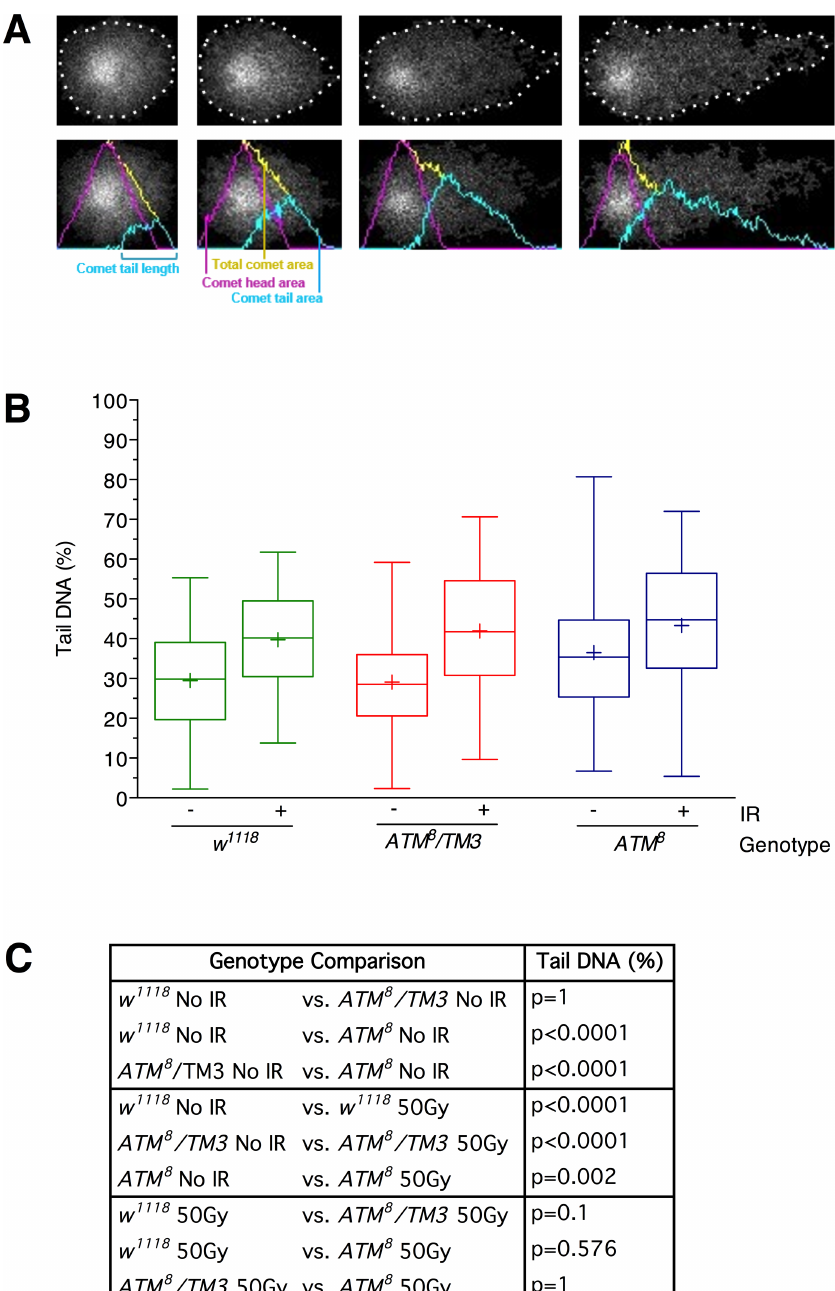
Fig 4. DNA damage accumulates in the brain of ATM 8 flies. (A, top row) Microscopy images of four examplesof individualcells subjectedto the Comet assay. The cells are arrangedleft to right from low to high levels of DNA damage.Dotted lines indicatethe area of electrophoresed DNA. (A, bottom row) Output from the CometScore Pro Software analysisof the cells shown in the top row. (B) The Comet assay was used to determine the percent tail DNA for brain cells of flies of the indicatedgenotypeand either not exposedto ionizingradiation(IR) (-) or exposedto 50 Gy of IR (+). All data points were graphedusing a box and whisker plot in Prism 7.0 (Graphpad) statistical software. Boxes indicate the middle 50% of the data points, lines in the middleof the boxes indicate the median, +s in the boxes indicatethe mean, and the maximum and minimum whiskersindicate 95% of the data points (minimum whisker begins at 2.5% and maximum whisker ends at 97.5%). > 200 comets were analyzedfor each condition. (C) P-values for data presented in panel B were basedon an unpairedequal-variance two-tail